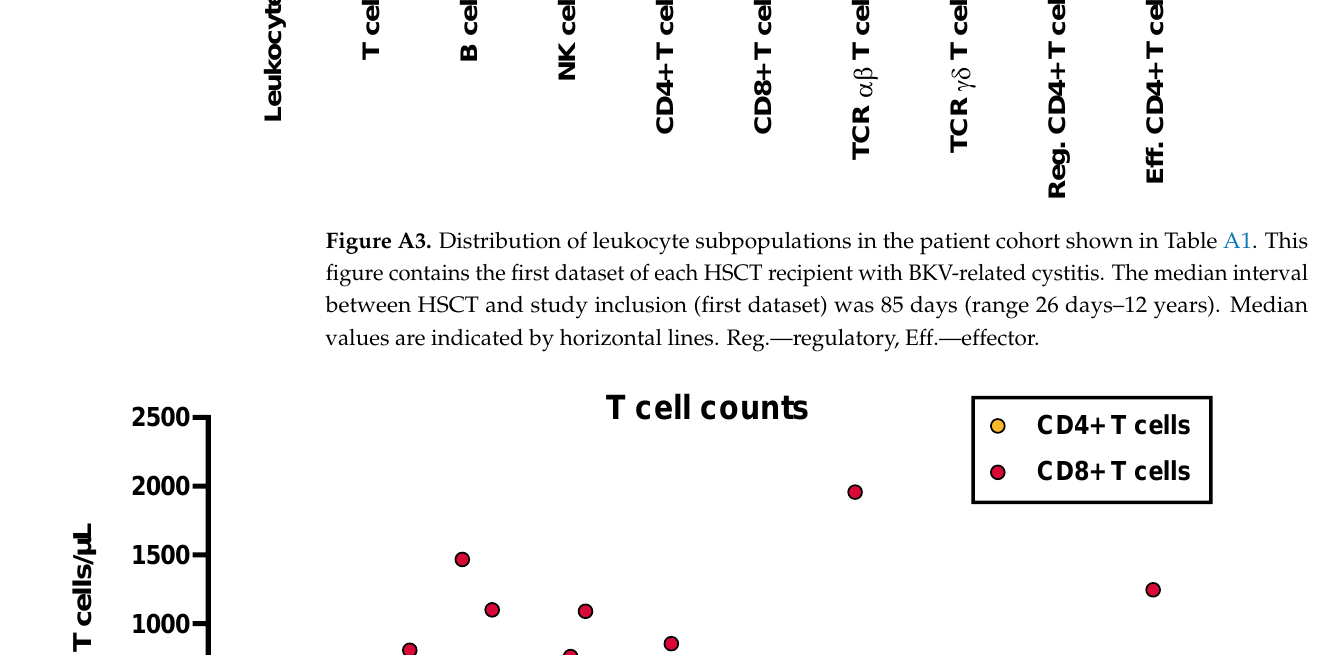
CD4+ and CD8+ T-cell counts in the patient cohort shown in Table A1. Spearman analysis indicated that CD4+ T-cell counts showed a stronger correlation with days after HSCT ( r = 0.46, p = 0.06) than